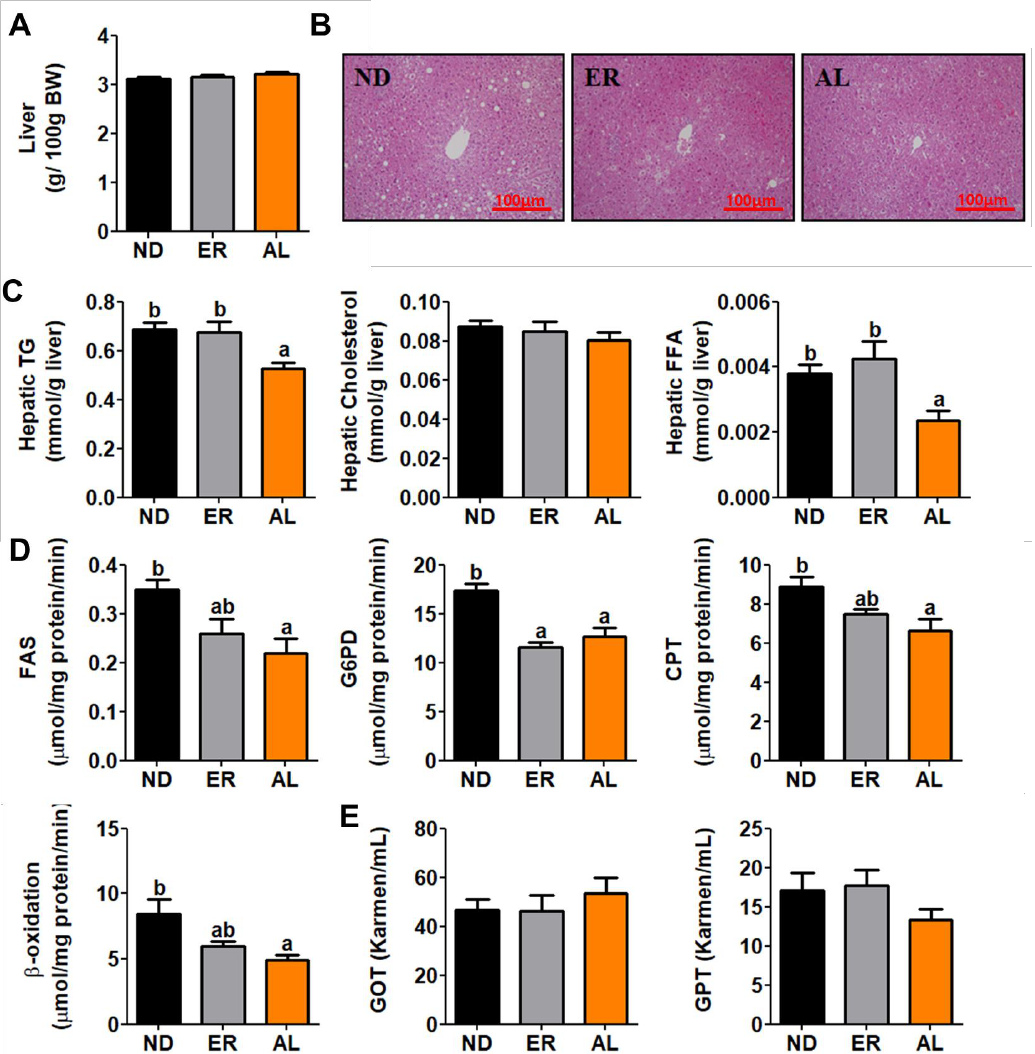
Figure 4. Effect of AL supplementation for 16 weeks on; liver weight ( A ), hepatic morphology ( B ), hepatic lipid contents ( C ), lipid-metabolism regulating enzyme activities ( D ), and hepatoxicity biomarkers ( E ).